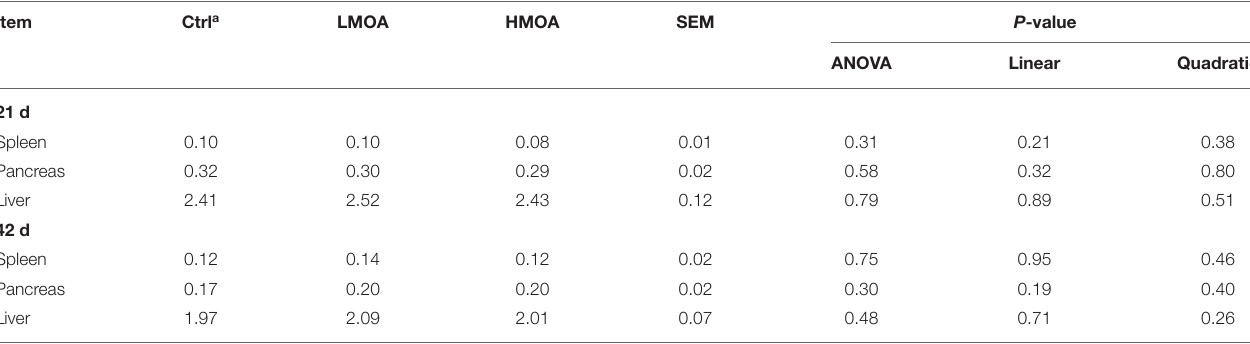
a − b In each row means with the same letter represented no significant differences. a Ctrl: a basal diet of corn-soybean meal with 0 mg/kg of mixed organic acid; LMOA: a basal diet with 3,000 mg/kg of mixed organic acids; HMOA: a basal diet with 6,000 mg/kg of mixed organic acids. n =